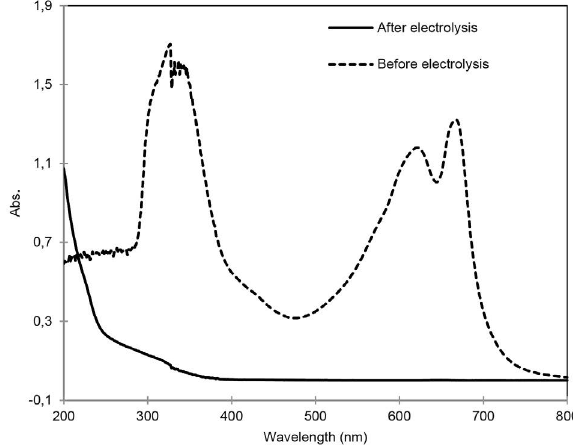
Figure 5. UV–Vis spectra for synthetic textile effluent before and after electrochemical treatment by using Co 47.5 /C 47.5 -PVC 5 elec- trode. ([NaCl] = 0.5 mol L –1 ; t = 45 min; E = 20 V; I = 0.93